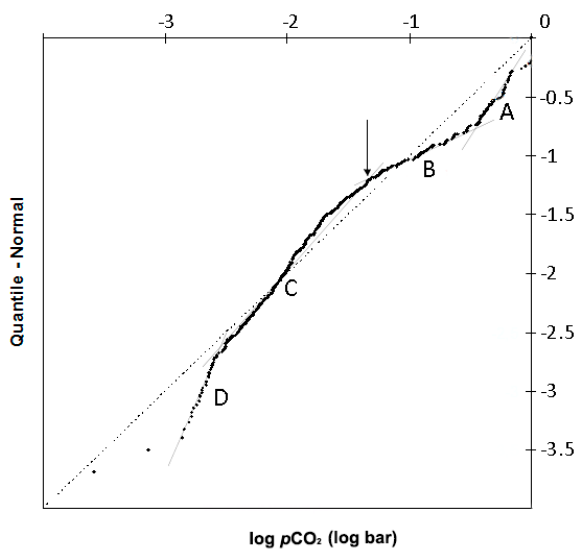
Figure 3. QQ plot of log p CO 2 values of the collected waters. The black arrow at the log p CO 2 value of − 1.347 (0.045 bar) separate the background populations ( A , B ) from those ( C , D ) where CO 2 partially derives from deep sources.